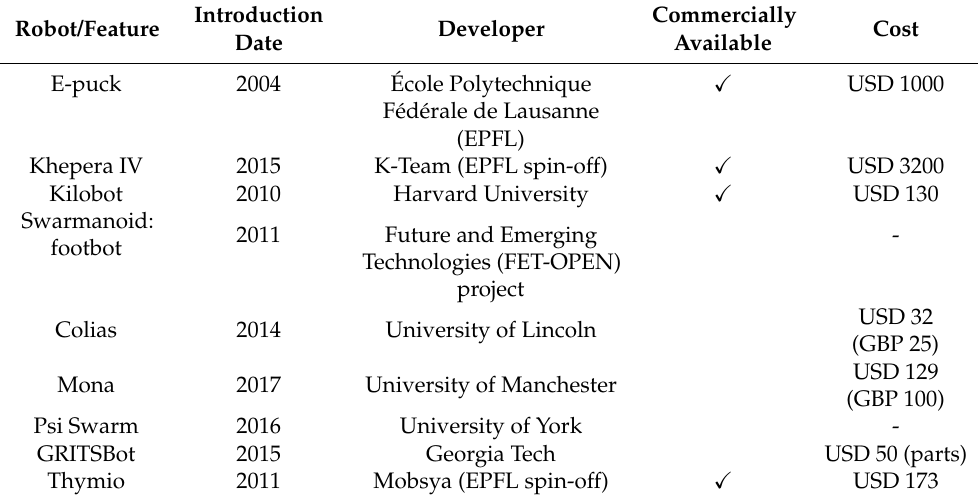
Table 2. Main robots for use in swarm robotics.